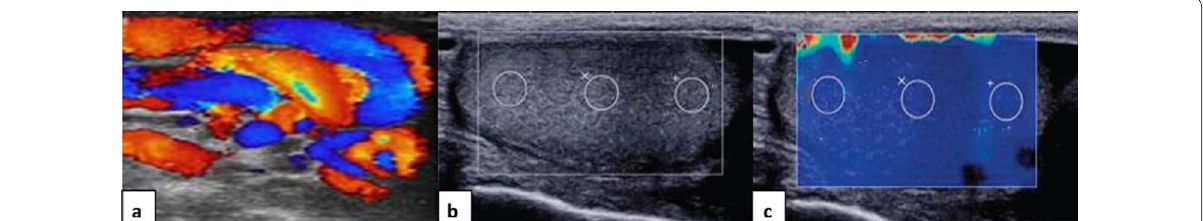
Fig. 4 A 39-year-old oligospermic patient with Lt. testicular varicocele. a Lt. testicular high-resolution ultrasound showed testicular varicocele (grade III). b , c Shear wave elastography of the Lt. testicle displayed homogenous blue color and increased mean testicular stiffness value